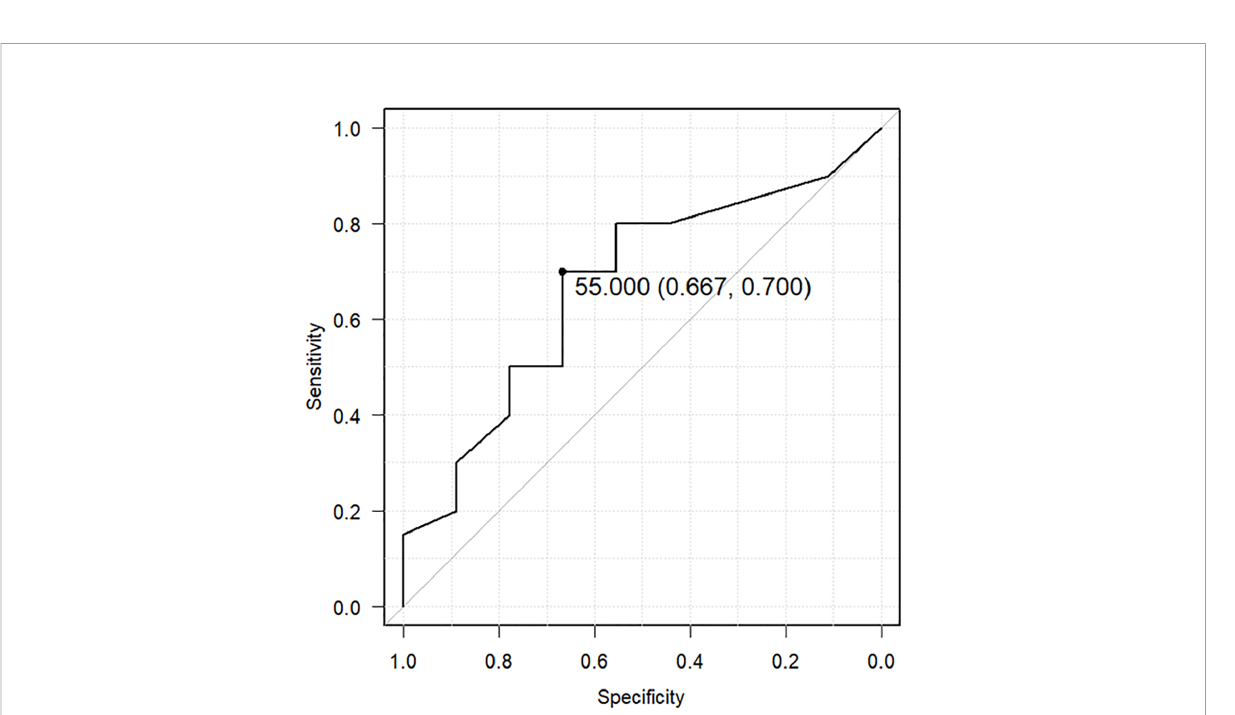
FIGURE 4 Receiver operating characteristic (ROC) curve predicting recurrent zinc de fi ciency using the lowest serum zinc concentration. The ROC curve predicts the recurrence of zinc de fi ciency using a cutoff of 55 m g/dL as the lowest serum zinc concentration (sensitivity: 0.667, speci fi city: 0.7, area under the ROC curve: 0.669, 95% con fi dence interval: 0.452 –